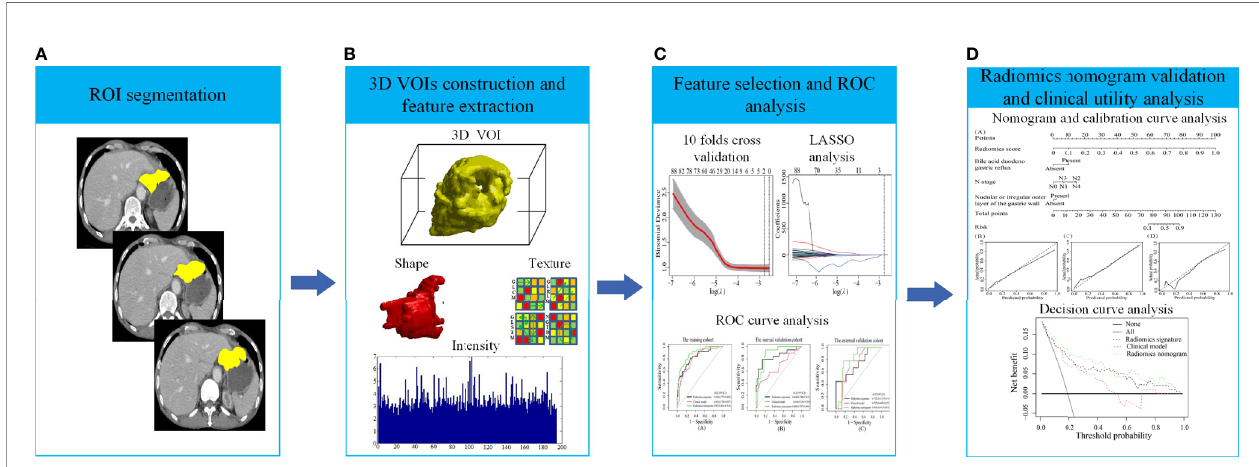
FIGURE 1 | The process of data analysis. (A) Region of interest (ROI) segmentation of gastric cancer (GC) lesions. (B) Three-dimensional reconstruction of the segmented GC lesions and feature extraction. (C) Feature selection and performance of the receiver operating characteristic (ROC) curve. (D) Performance of the radiomics nomogram and clinical utility.